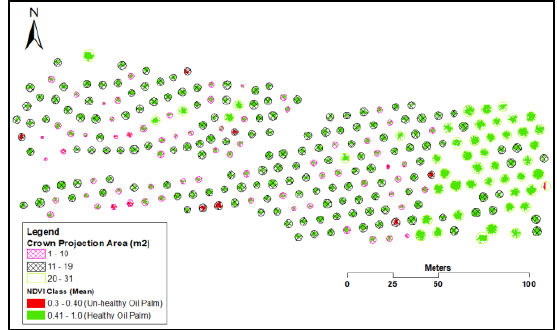
Figure 5. Spatial Distributions of Oil Palm